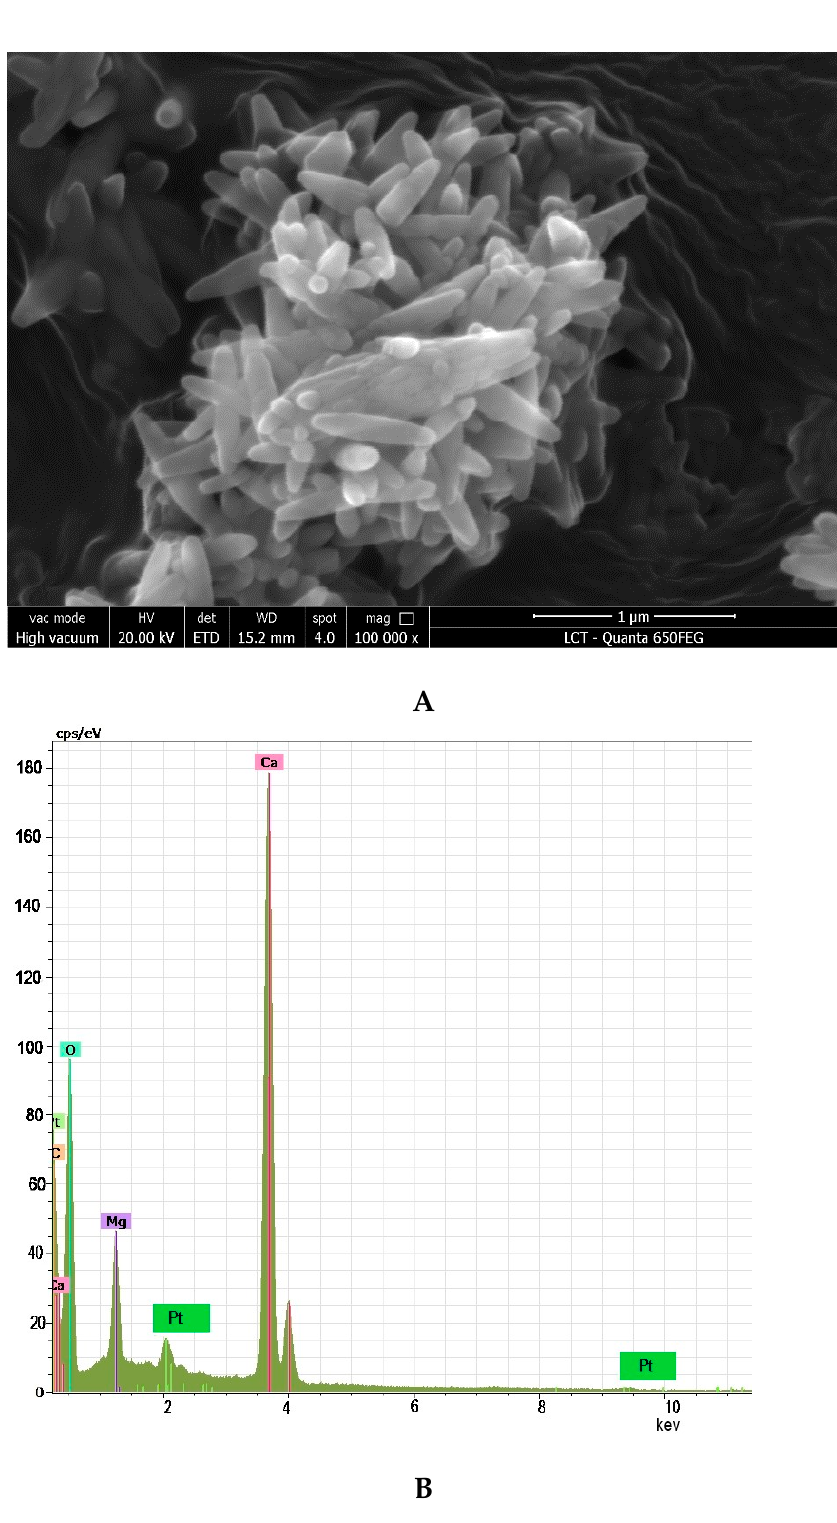
Figure 4. ( A ) Scanning electron microscopy (SEM) images with a magnification of 100,000× that demonstrated scalenohedral crystals for the inorganic mineral CaCO 3 . ( B ) Energy ‐ dispersive spectroscopy (EDS) analysis: from the information contained in the EDS spectrum it is possible to obtain quantitative information on the sample composition on a microscopic scale. In the spectrum, Platinum (Pt), Carbon (C), Oxygen (O) and Magnesium (Mg) were identified, in addition to Calcium (Ca).